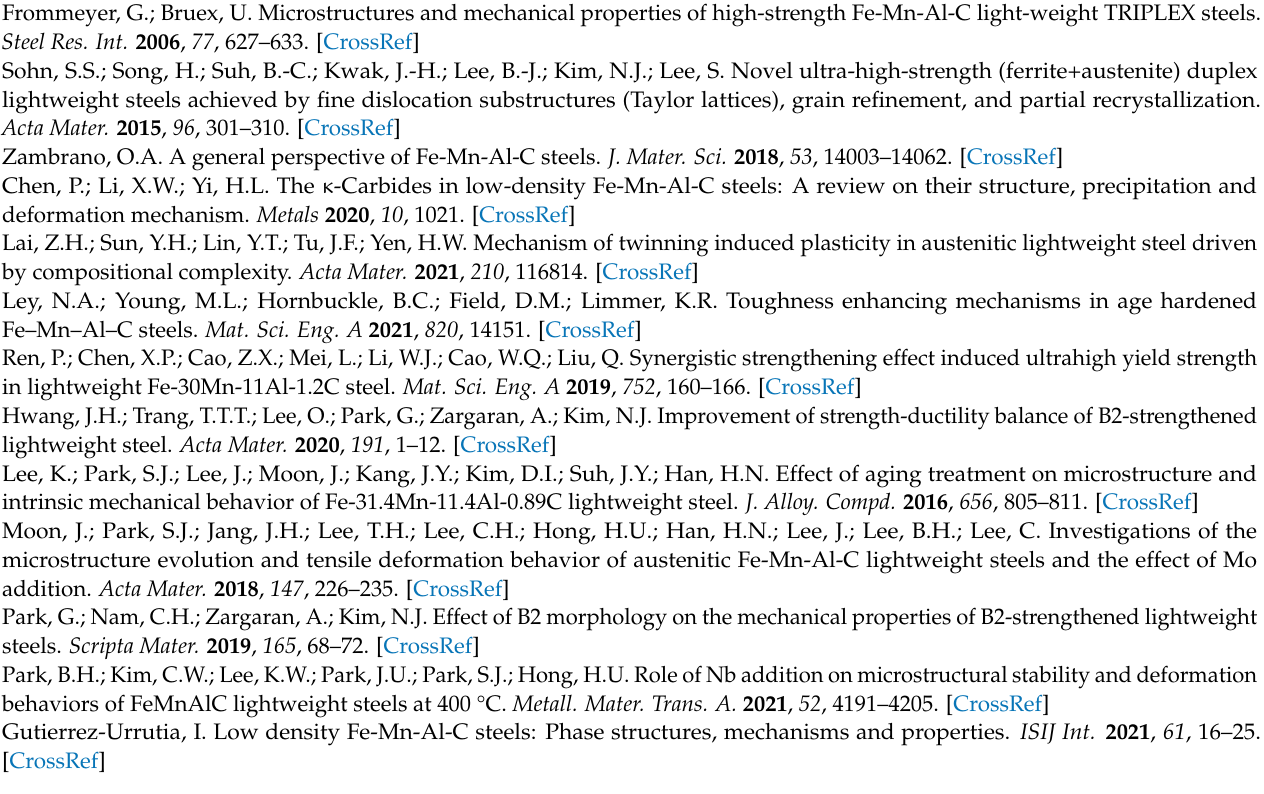
Adding a Cu element to Fe-Mn-Al-C lightweight steel and equipping it with a reason- able heat treatment process can realize the co-precipitation of fine Cu-rich particles and fine κ -particles in grains. Further, it can alleviate the problem that it is diffi- cult to have both strength and toughness and plasticity, and significantly improves the hydrogen-induced fracture properties of lightweight steel. However, the co- precipitation relationship (precipitation sequence, interdependence, interaction, etc.), and co-precipitation mechanism of Cu-rich particles and κ -carbide particles are not clear. Therefore, strengthening this research is of great significance to further improve the comprehensive properties of Fe-Mn-Al-C lightweight